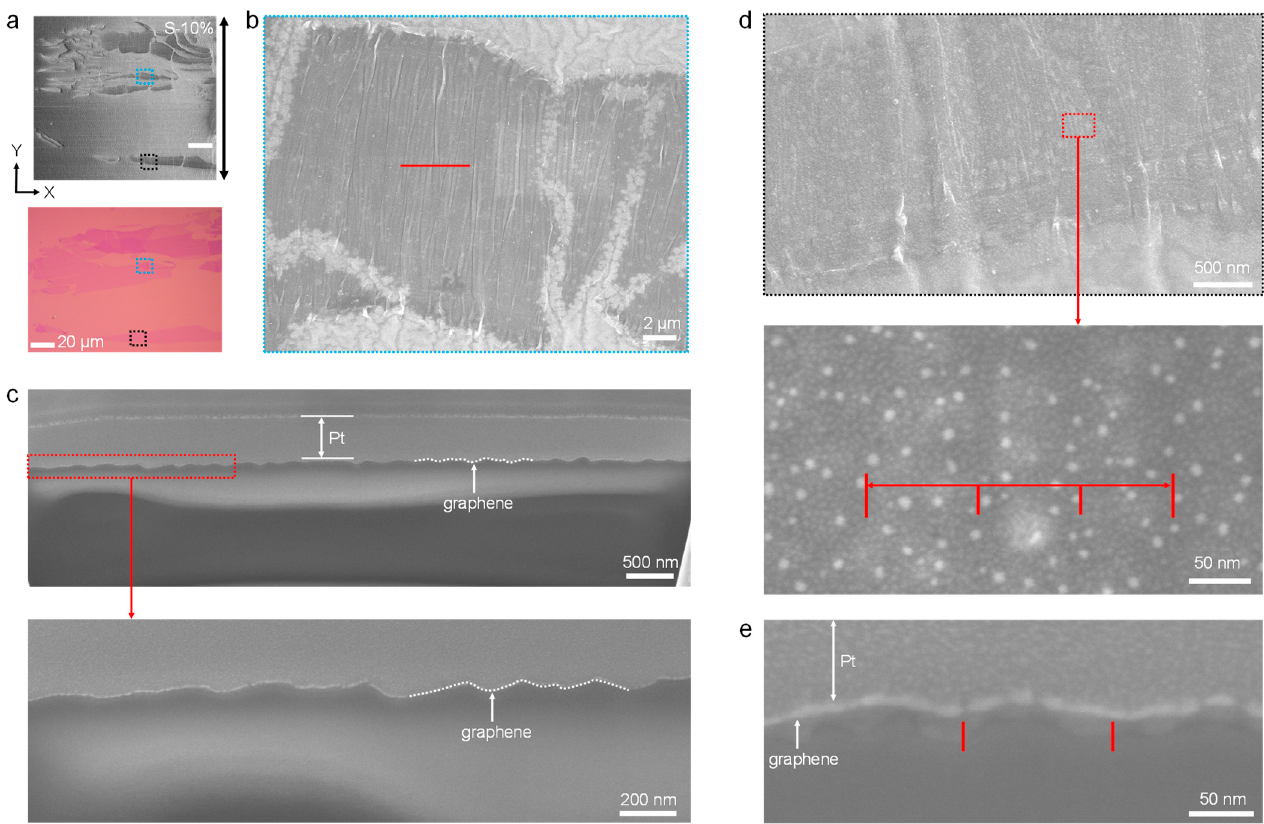
Figure 2. Experimental results on the buckling behavior of few-layer graphene. ( a ) Top panel, scanning electron microscopy (SEM) image showing a bilayer of graphene/PDMS with mechanical stretching of 10%. Lower panel, the graphene on the Si wafer, the same as the lower panel of Figure 1a. ( b ) Enlarged image of the light blue dotted frame region in ( a ), showing the buckling behavior of the three-layer graphene. ( c ) Top panel, focused ion beam (FIB) image showing the cross-section of wrinkles of three-layer graphene, with the milled location marked by a red line in ( b ). Lower panel, enlarged image of the red dotted frame region in the top panel. “Pt” indicates platinum film, which is needed to mill the cross-section by FIB. The cross-section of the few-layer graphene is marked by a white dotted line. ( d ) SEM images, top panel, enlarged image of the black dotted frame region in ( a ) showing the wrinkle pattern in monolayer graphene. Lower panel, enlarged image of the three wrinkles marked with red dotted frame on the top panel. ( e ) FIB image showing the cross-section of three wrinkles in monolayer graphene.